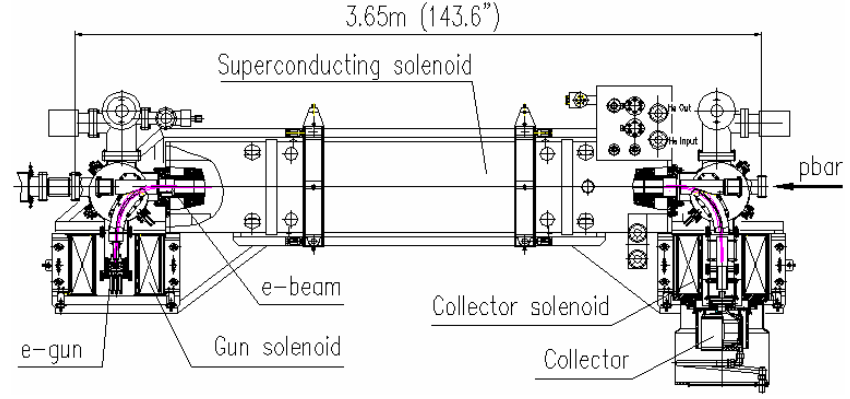
FIG. 10. Layout and main components of the first Tevatron electron